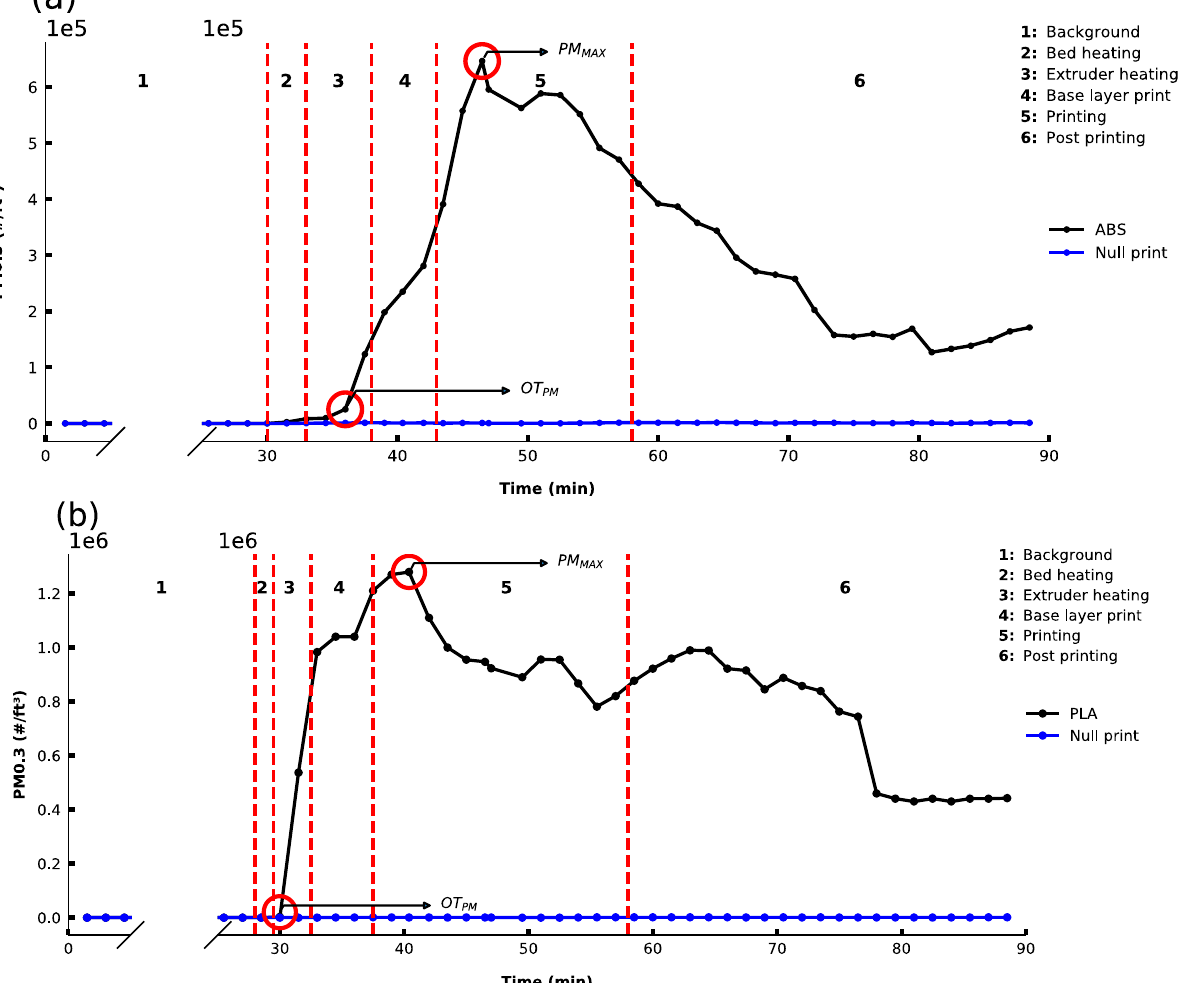
Figure 1. PM 0.3 profiles over time before, during, and after printing of a cube (20 mm × 20 mm × 20 mm) for ( a ) ABSB1b (bedplate temperature: 80 °C; extruder temp: 245 °C, 0% fan, 20% infill) and ( b ) PLAB1b (bedplate temperature: 50 °C; extruder temp: 205 °C, 20% fan, 20% infill).